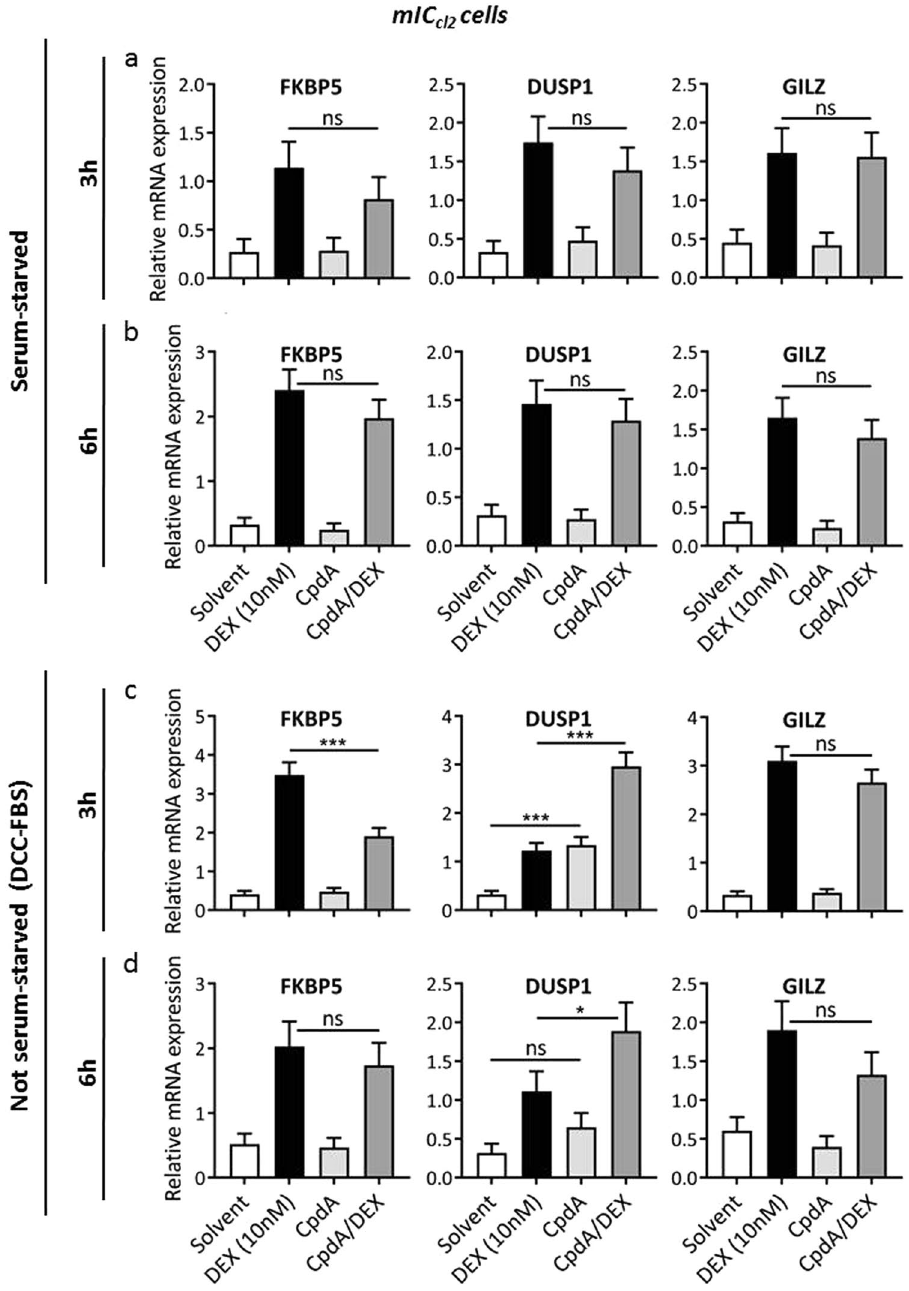
Figure 4. The effect of CpdA on DEX-induced gene expression is more pronounced in mIC cl2 cells, in the presence of serum. ( a ) Serum-starved mIC cl2 cells were pre-incubated with CpdA (10 µ M) for 1 h, after which DEX (10 nM) was added for 2 h. Total RNA was extracted and subjected to RT-qPCR. Expression values were normalized to the reference genes Cyclo and HPRT using qBase + . Four independent replicates were performed. Means + SE, obtained as predictions from the HGLMM fitted to the data, are shown on the original scale for FKBP5, DUSP1 and GILZ. ( b ) Serum-starved mIC cl2 cells were pre-incubated with CpdA (10 µ M) for 1 h, after which DEX (10 nM) was added for 5 h. Total RNA was extracted and subjected to RT-qPCR. Expression values were normalized to the reference genes Cyclo and HPRT using qBase + . Three independent replicates were performed. Means + SE, obtained as predictions from the HGLMM fitted to the data, are shown on the original scale for FKBP5, DUSP1 and GILZ. ( c ) mIC cl2 cells were pre-incubated with CpdA (10 µ M) for 1 h, after which DEX (10 nM) was added for 2 h. Total RNA was extracted and subjected to RT-qPCR. Expression values were normalized to the reference genes Cyclo and HPRT using qBase + . Three independent replicates were performed. Means + SE, obtained as predictions from the HGLMM fitted to the data, are shown on the original scale for FKBP5, DUSP1 and GILZ ( d ) mIC cl2 cells were pre-incubated with CpdA (10 µ M) for 1 h, after which DEX (10 nM) was added for 5 h. Total RNA was extracted and subjected to RT-qPCR. Expression values were normalized to the reference genes Cyclo and HPRT using qBase + . Three independent replicates